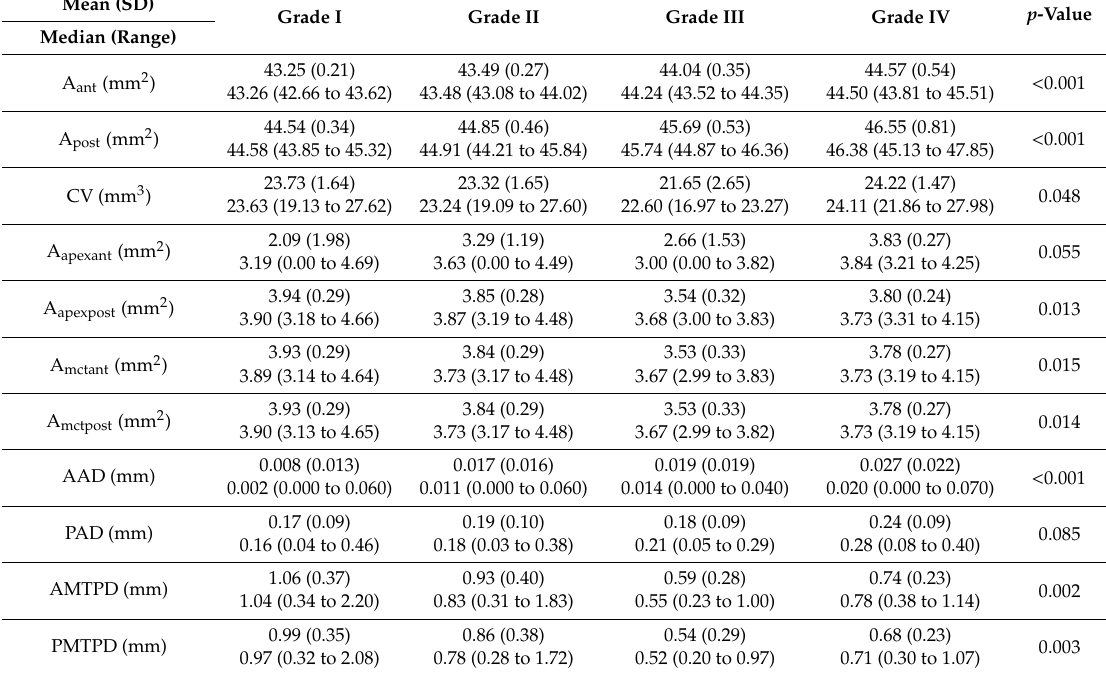
Table 2. Summary of the morphogeometric data obtained in the evaluated sample according to the level of severity of the disease defined using the RETICS grading system. Abbreviations: SD, standard deviation; A ant , anterior corneal surface area; A post , posterior corneal surface area; CV, corneal volume; A apexant , sagittal plane area at anterior apex; A apexpost , sagittal plane area at posterior apex; A mctant , sagittal plane area at anterior minimum thickness point; A mctpost , sagittal plane area at posterior minimum thickness point; AAD: anterior apex deviation; PAD, posterior apex deviation; AMTPD, anterior minimum thickness point deviation; PMTPD, posterior minimum thickness point deviation. Mean